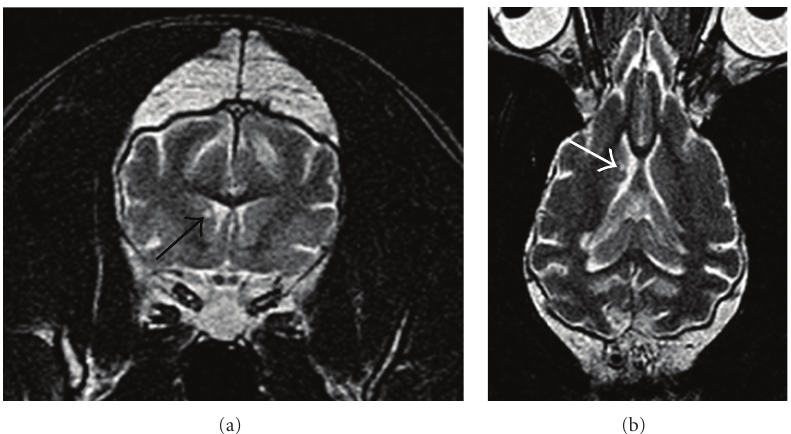
Figure 1: T2-weighted images at the level of the caudate nuclei in the transverse (a) TR = 3500, TE = 90) and dorsal plane (b) TR = 3500, TE = 99) in a dog with monocytic ehrlichial meningoencephalitis. There is a subtle, punctate, hyperintense lesion of the right caudate nucleus consistent with arterial infarction and/or perivascular inflammation (arrows).